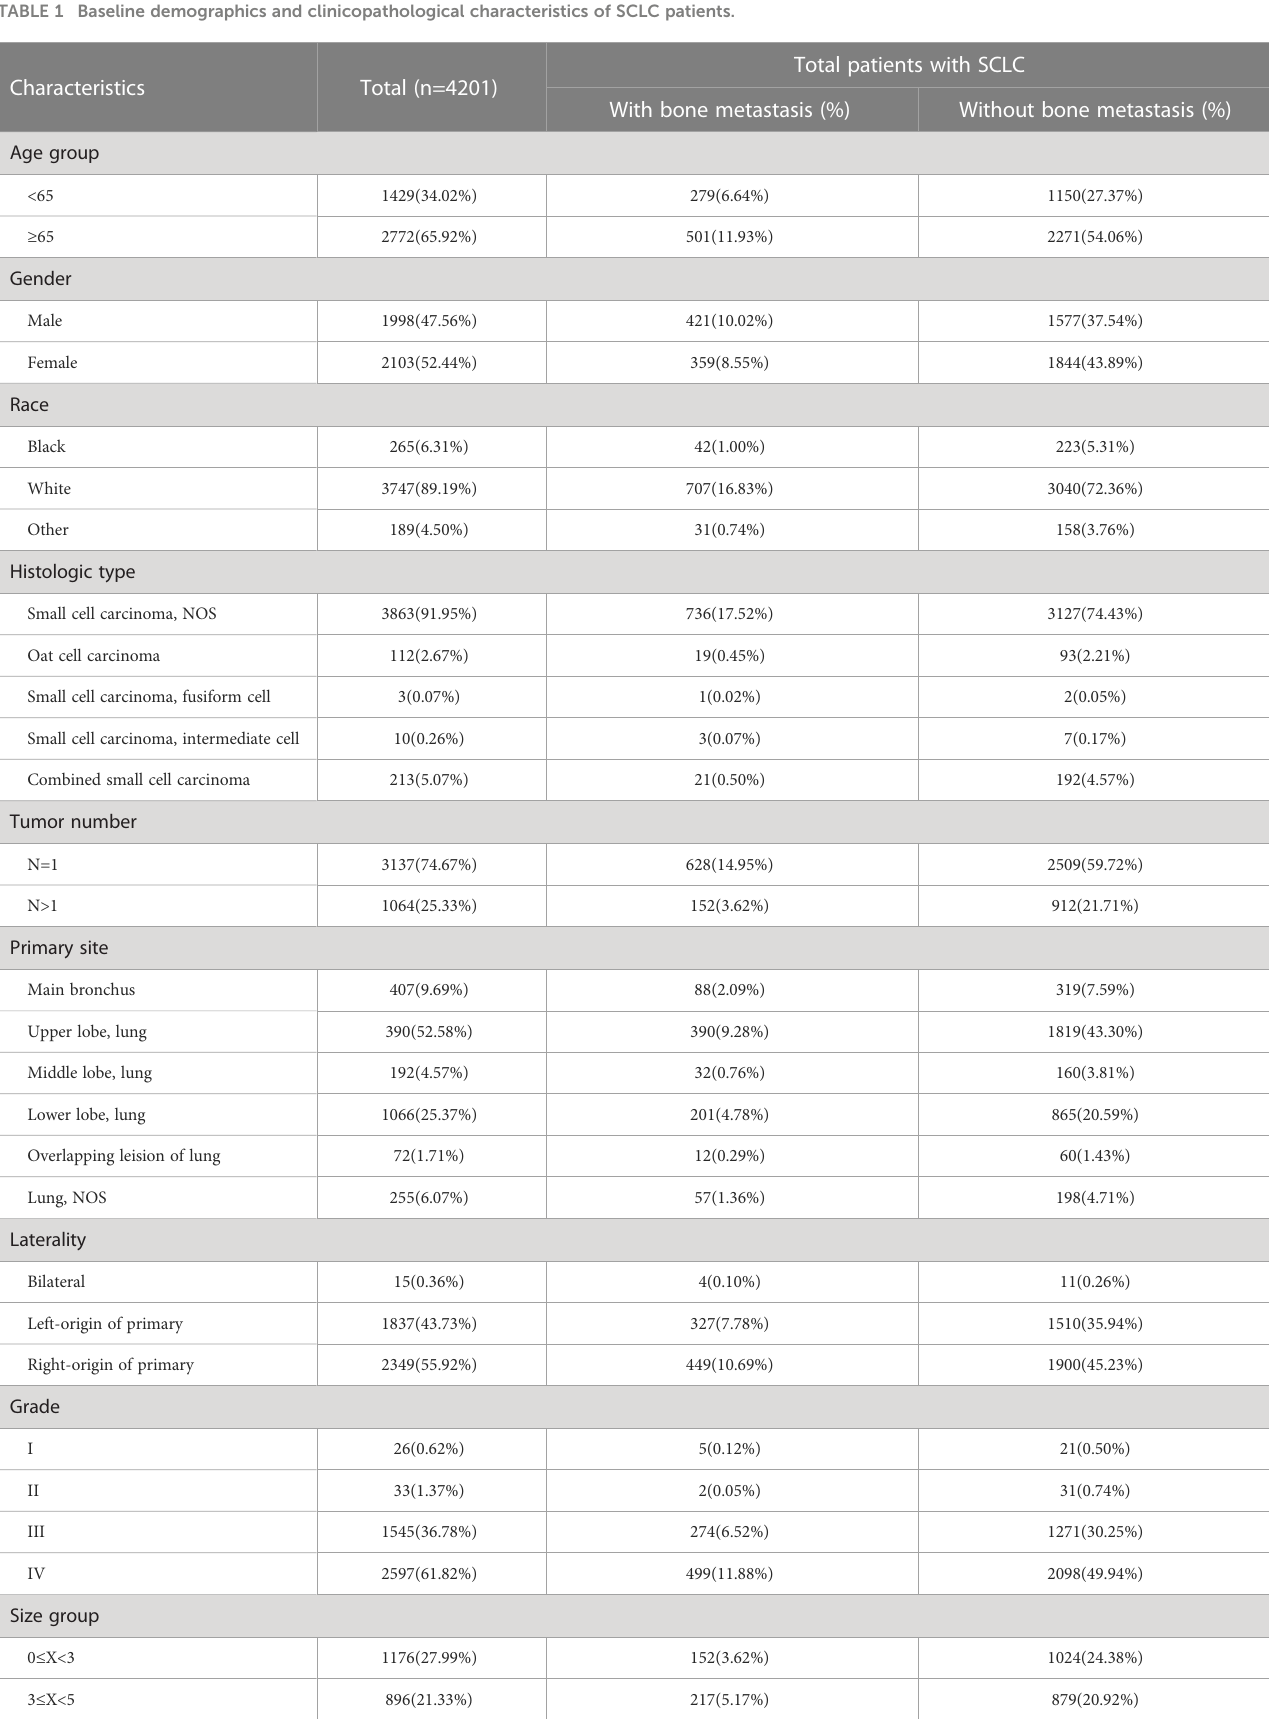
TABLE 1 Baseline demographics and clinicopathological characteristics of SCLC